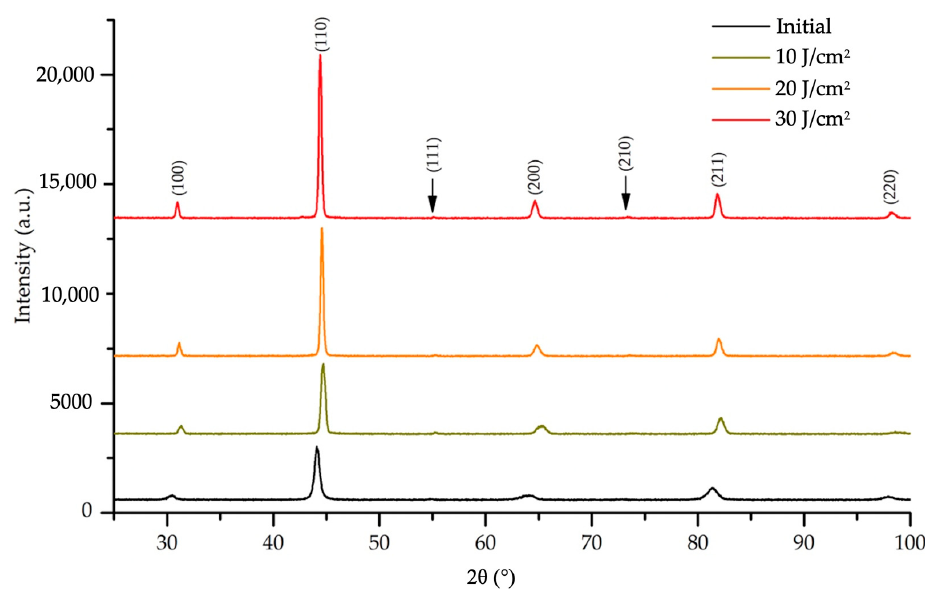
Figure 12. XRD patterns of HEA sample modified with HCPEB with the different energy densities. Summarizing the results obtained in the EDS analysis of the initial HEA sample and the material modified by HCPEB characterize an inhomogeneity degree in the distribution of alloying elements in the surface layer presented in Figure 13.